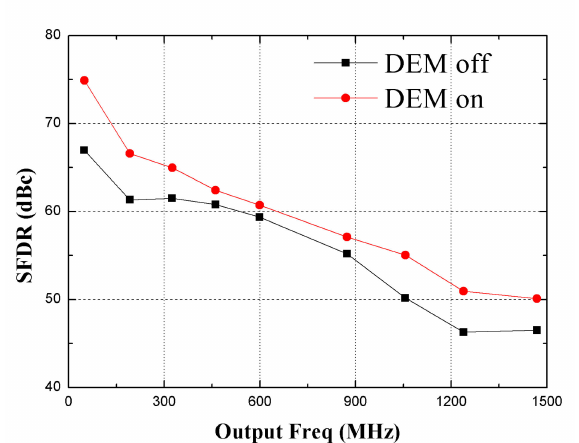
Figure 10. The spurious-free dynamic range (SFDR) comparison with DEM o ff and